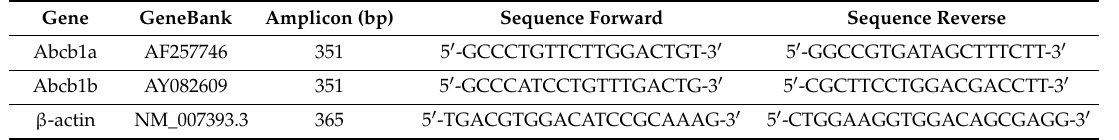
Table 5. Primer characteristics of Abcb1a, Abcb1b and β